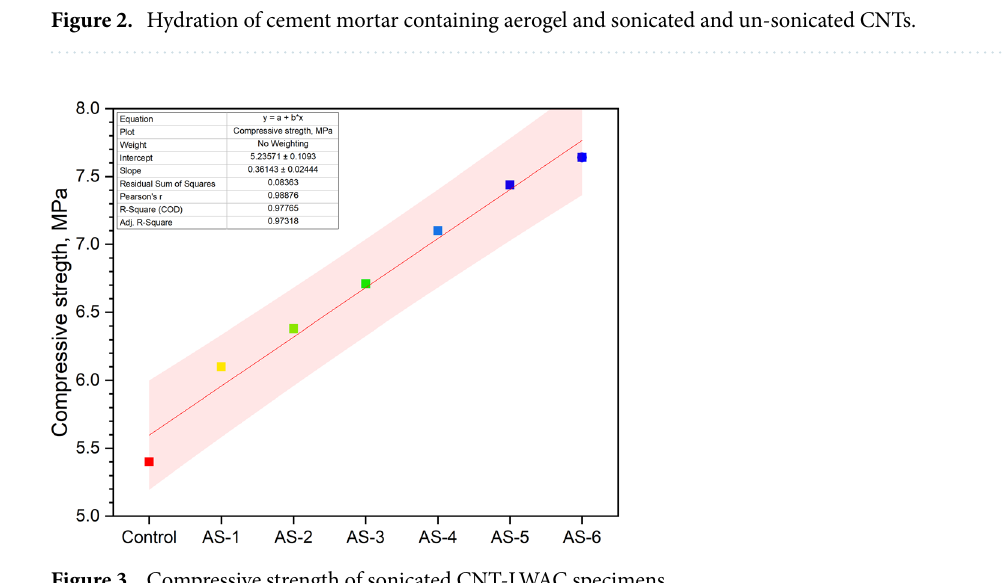
Figure 3. Compressive strength of sonicated CNT-LWAC